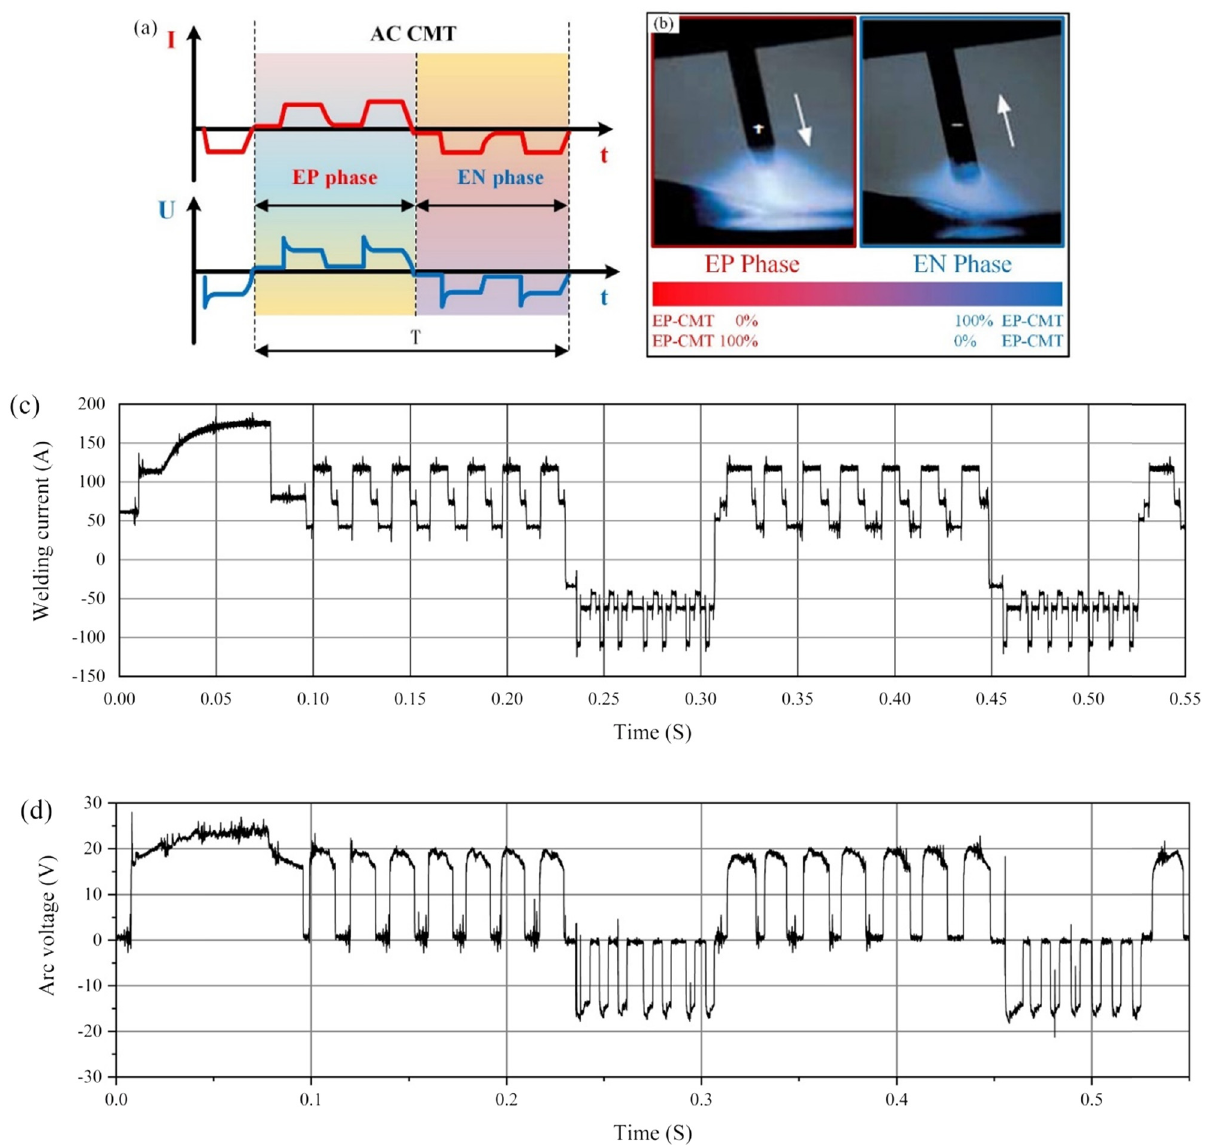
Figure 5: The characteristics of EP phase and EN phase of AC CMT: ( a ) AC CMT current and voltage, ( b ) arc morphology of different phases of AC CMT, ( c ) AC CMT current waveform coupled with high - frequency pulse current, and ( d ) AC CMT voltage waveform coupled with high - frequency pulse